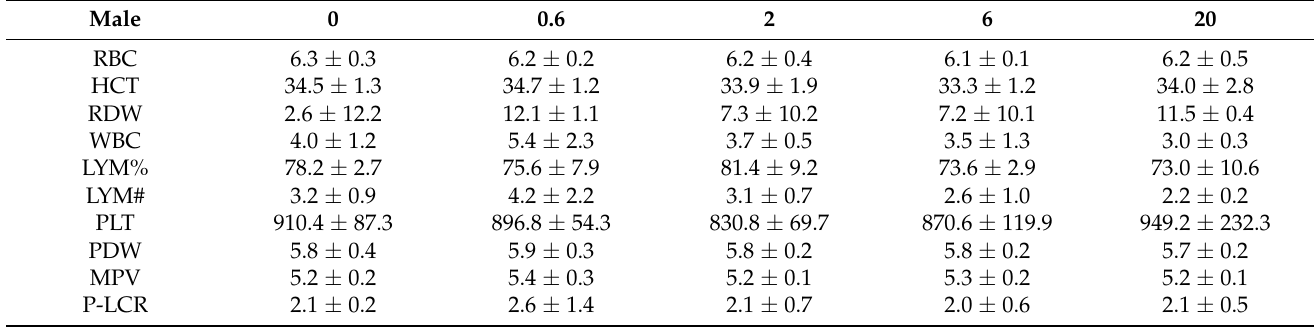
Table 1. Changes of hematological parameters of ICR mice after feeding the FANC for 14 days.